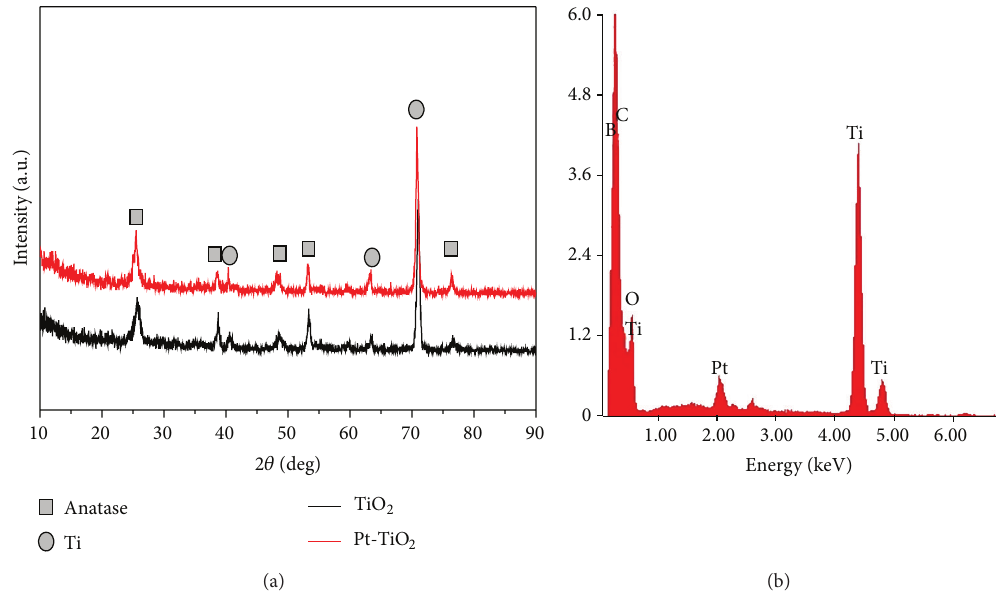
Figure 1: XRD patterns of TiO 2 and Pt-TiO 2 nanosheet films.